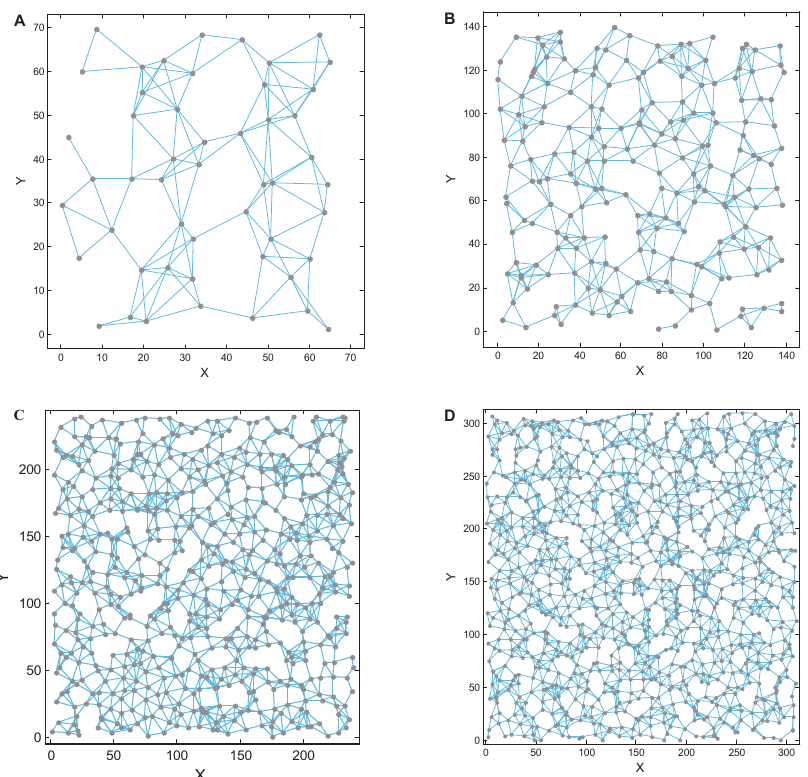
Figure 5. Gateway deployment of a 7-node network. ( A ) 50 nodes; ( B ) 200 nodes; ( C ) 600 nodes; ( D ) 1000